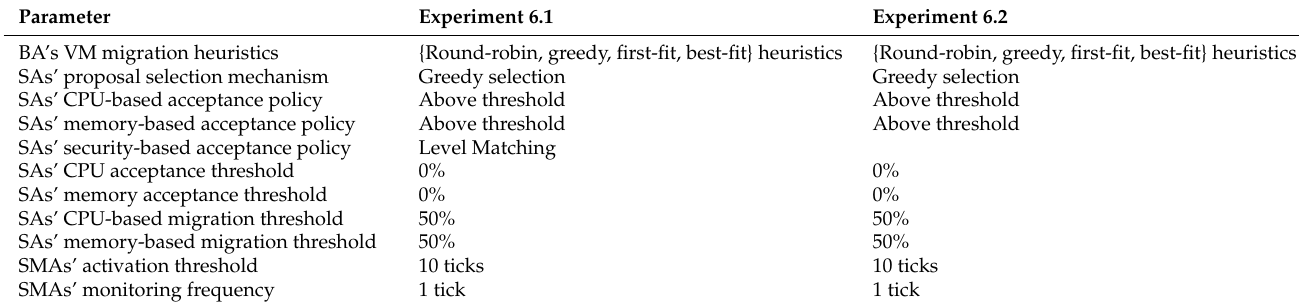
Table 3. Agent-based testbed parameters for